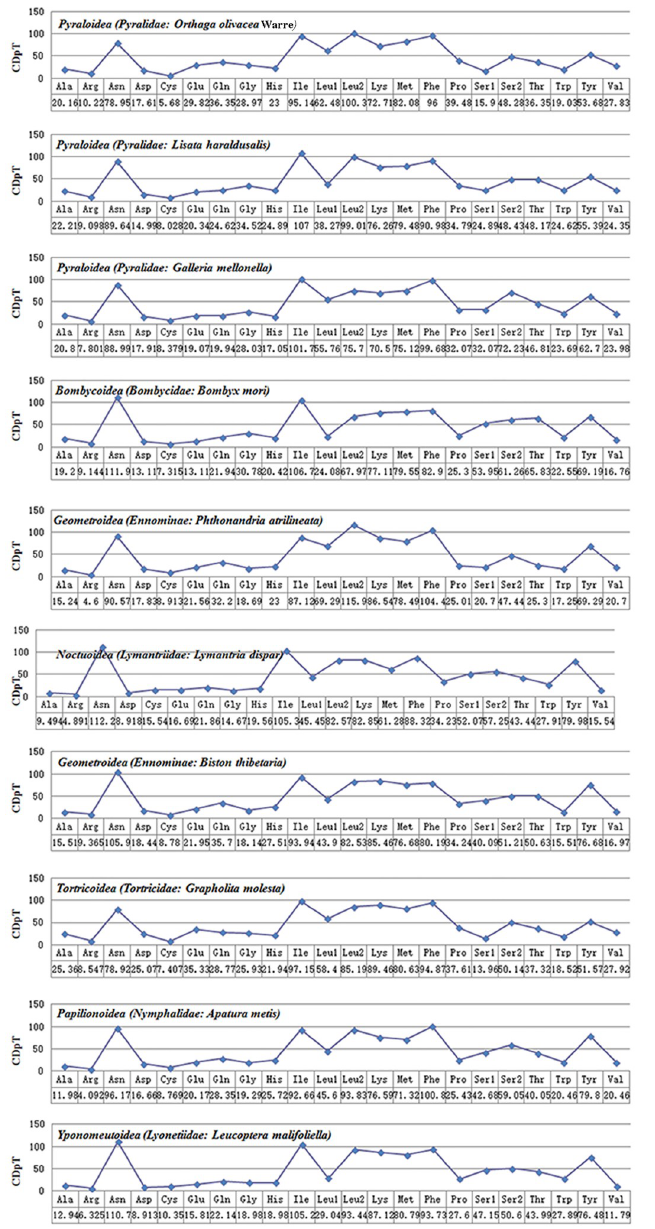
Fig 3. Codon distribution of O . olivacea Warre compared with other species of the Lepidoptera. CDspT = codons per thousand codons.